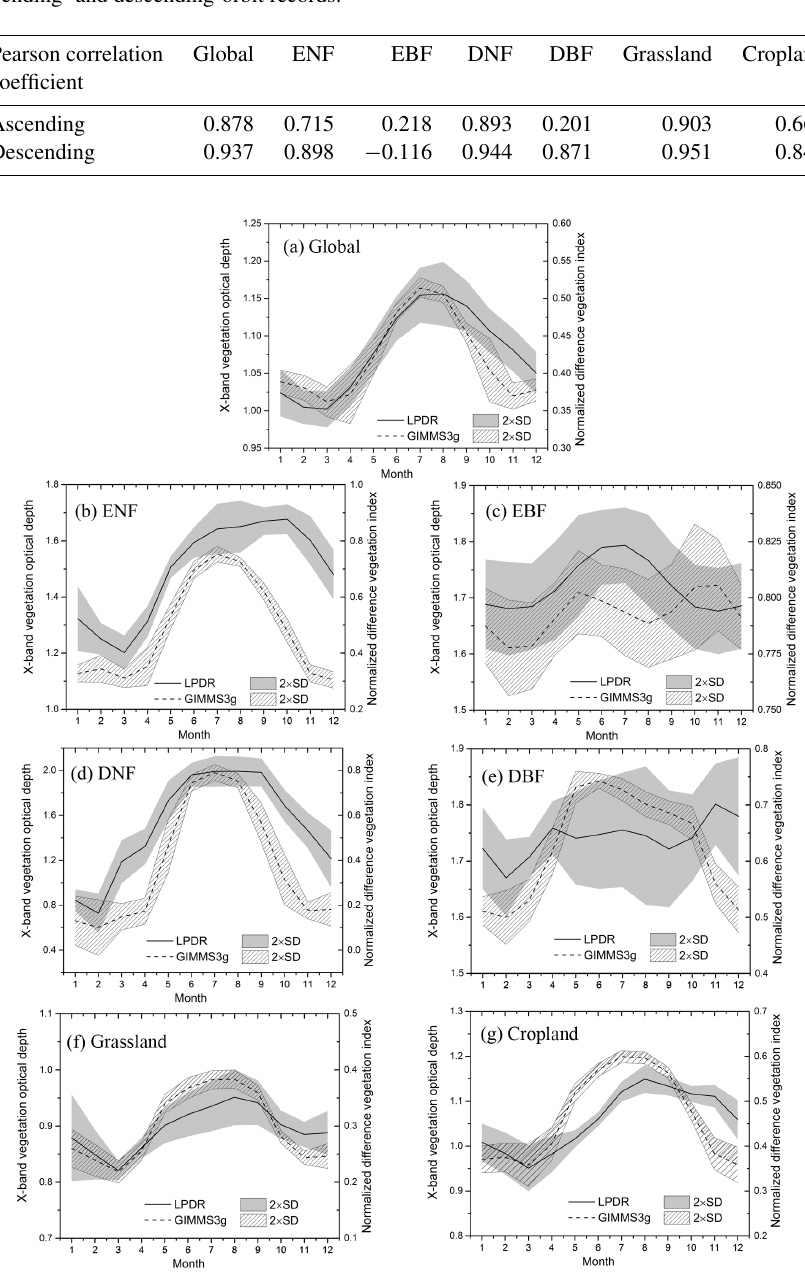
Table 3. Pearson correlations ( R ) between LPDR VOD and GIMMS3g NDVI climatology monthly means for the aggregate 2003–2010 and 2013–2015 observation record. The comparisons were made for all global vegetation and selected land cover areas, including ENF, EBF, DNF, DBF, grassland, and cropland. Both products were projected into a consistent 25.0km resolution EASE-Grid format. VOD results are delineated for LPDR ascending- and descending-orbit records.